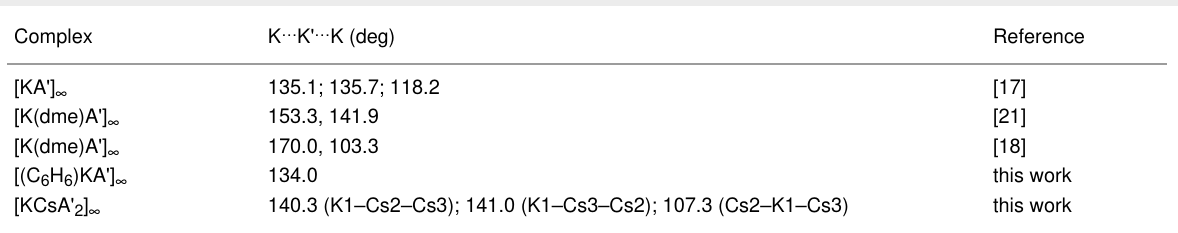
Table 2: Non-bonded intrachain K … K' … K angles in [L n KA'] complexes.